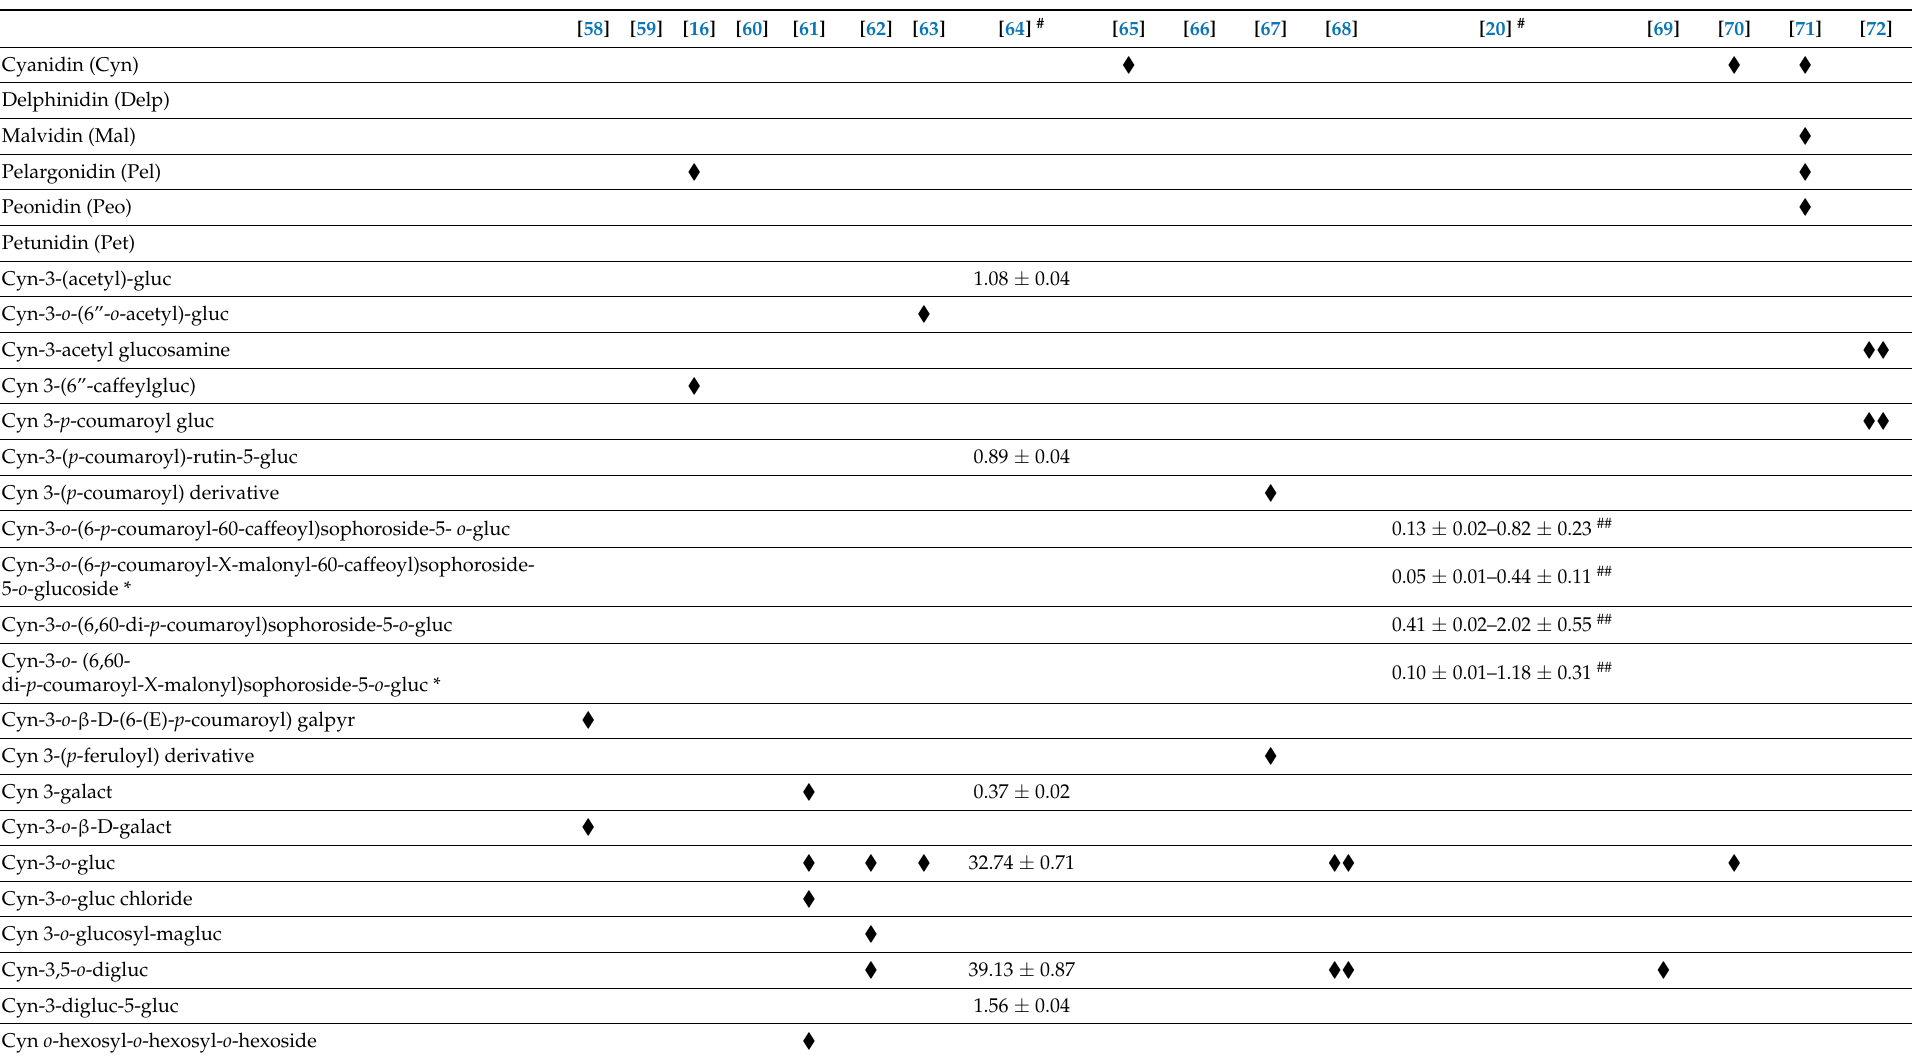
Table 3. Anthocyanins identified or quantified in edible plant